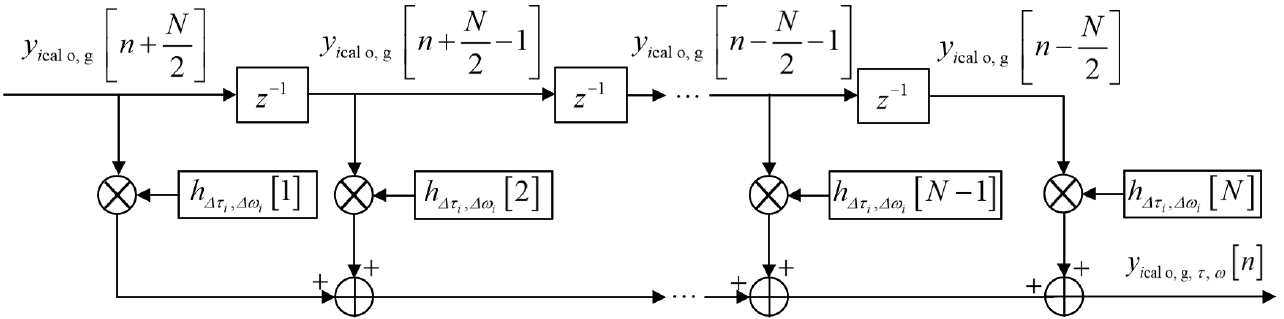
Figure 3. Proposed structure of correction time skew and bandwidth mismatch.